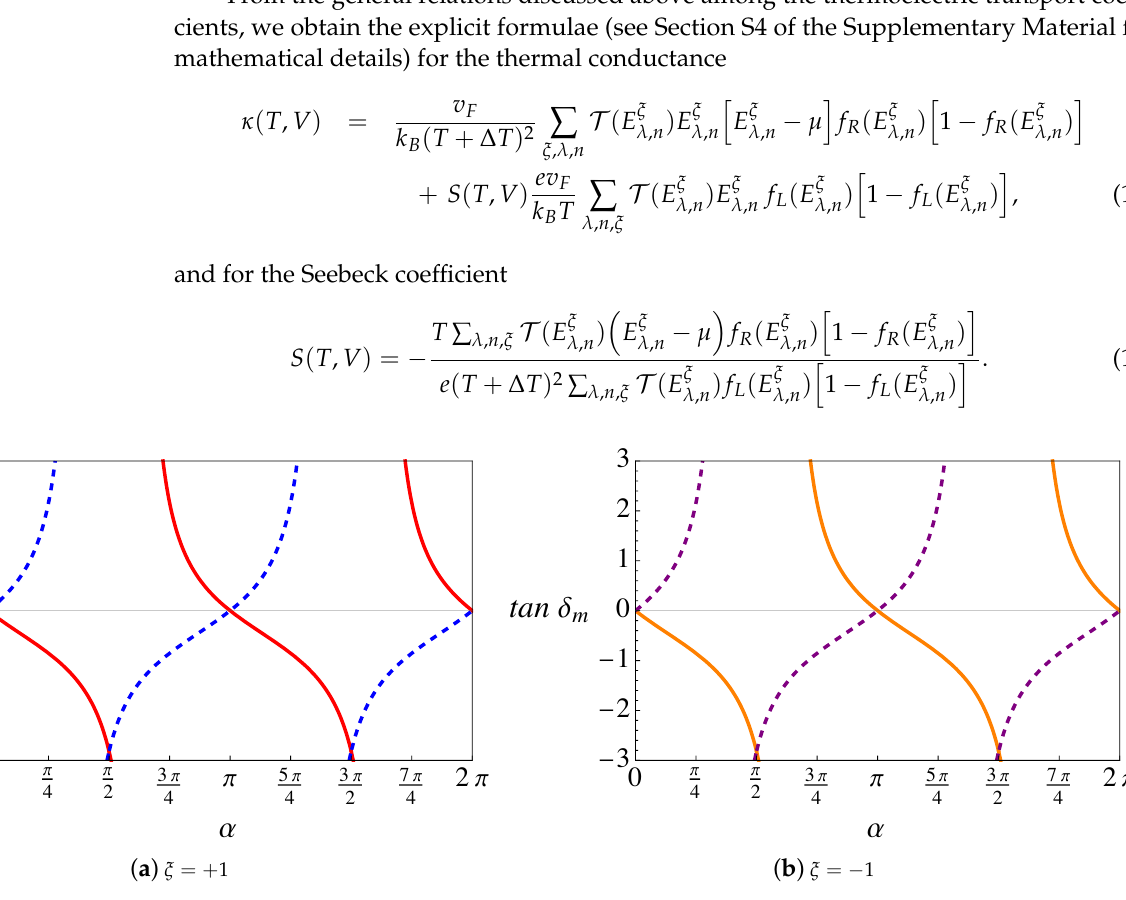
Figure 2. (Color online) Analytical expression for tan δ m (in Equation (S29) in Supporting Information) plotted as a function of α . The plots are computed for a wave vector k ⊥ ∼ 1/ a and an orbital angular momentum m = 1. ( a ) Node index ξ = 1; the red (solid) line corresponds to a band index λ = 1 and the blue (dashed) line is for λ = − 1. ( b ) Node index ξ = − 1; the orange (solid) line corresponds to a band index λ = 1 and the purple (dashed) line is for λ = −